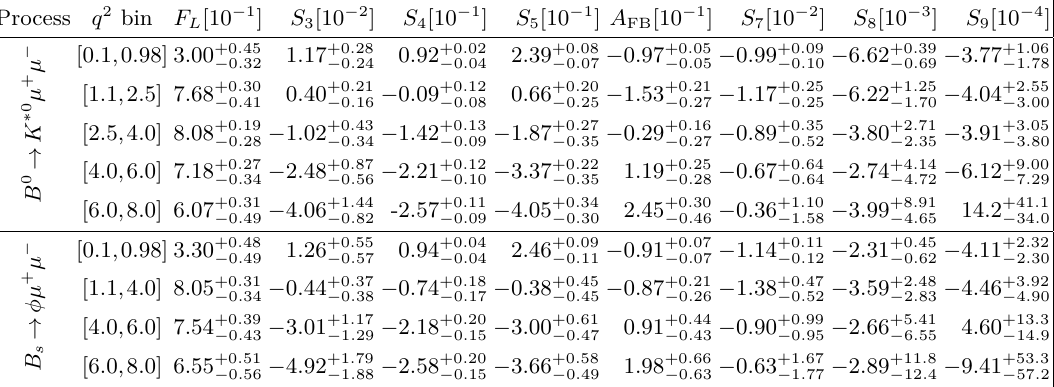
Table 12 . SM predictions for the angular observables for the B 0 → K ∗ 0 µ + µ − and B s → φµ + µ − decays. Note that we provide the central 68% intervals and that the posterior-predictive distribu- tions are not